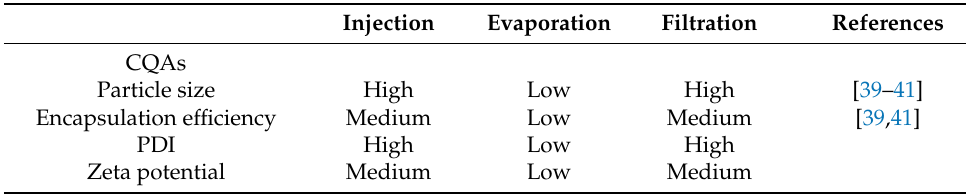
Table 2. Risk analysis based on critical parameter process.